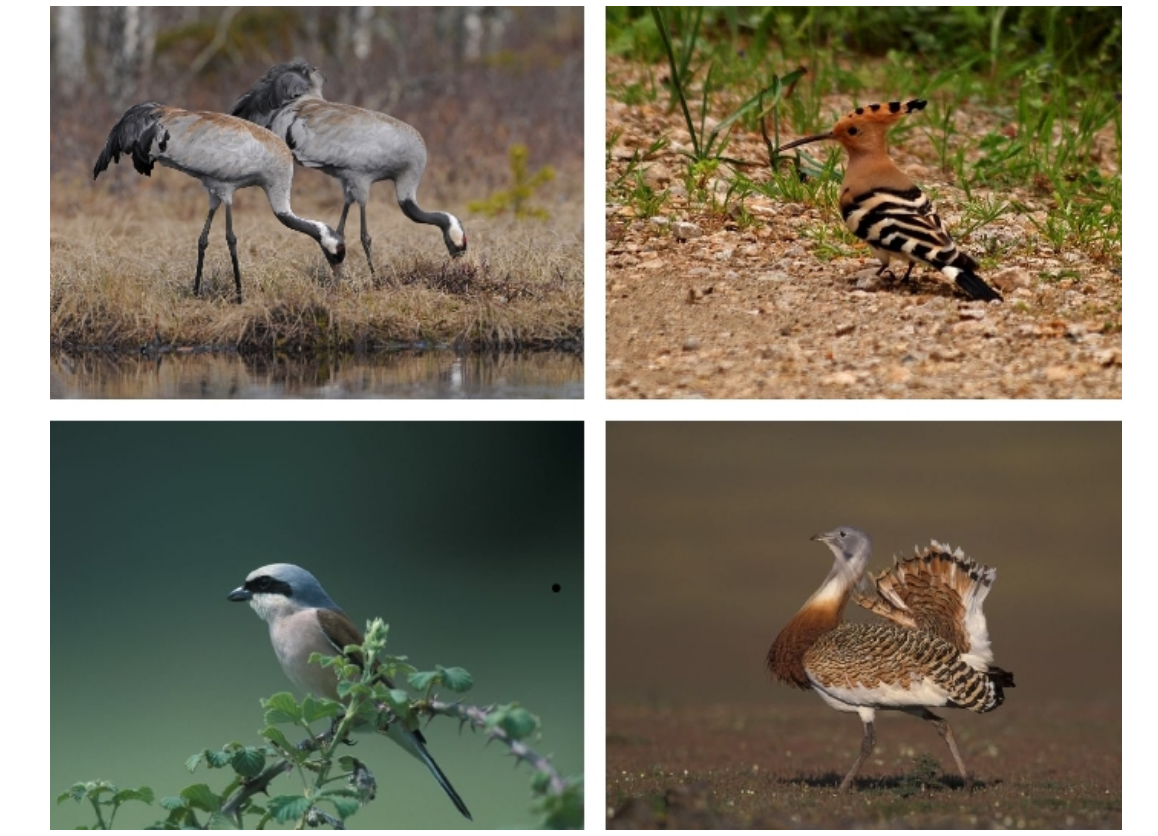
Fig. 5 . Bird species of European conservation concern that are indicative of HNV (high-nature-value) farmland (from upper left to lower right): a) Common Crane ( Grus grus ), b) Eurasian Hoopoe ( Upupa epops ), c) Red-backed Shrike ( Lanius collurio ), d) Great Bustard ( Otis tarda ). Courtesy of Jörg Mager (a), Hans Dekker (b), Urska Koce (c), and Arie de Knijff